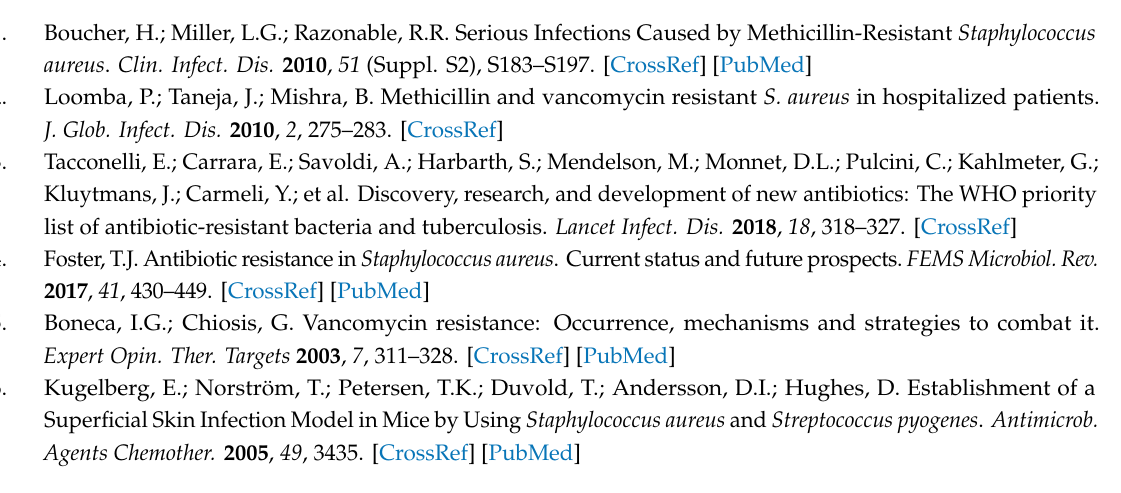
Figure S1: (a) SEM and (b) EDS elemental mapping. (c–h) stands for chloride, ruthenium, very less amount of carbon, negligible presence of sulphur, high amount of nitrogen, and less amount of oxygen; Figure S2: EDS spectrum where presence of ruthenium with high concentration of nitrogen can be seen; Figure S3: Growth curve of RuCl3 treated VRSA (CCM 1767); Figure S4: Growth curve of RuCl3 treated MRSA (ST239: SCCmecIIIA); Figure S5: Growth curve of 2-(1H-benzimidazol-2-ylmethylsulfanylmethyl)-1H-benzimidazole treatment against VRSA (CCM 1767); Figure S6: Growth curve of 2-(1H-benzimidazol-2-ylmethylsulfanylmethyl)-1H-benzimidazole treatment against MRSA (ST239: SCCmecIIIA); Figure S7: Growth curve of Schiff base 2- [(E)-1H-1,2,4-triazol-5-yliminomethyl] phenol treatment against VRSA (CCM 1767); Figure S8: Growth curve of Schiff base 2-((E)-1H-1,2,4-triazol-5-yliminomethyl) phenol treatment against MRSA (ST239: SCCmecIIIA); Figure S9 (a) cytotoxicity for RU-S4 against the human cell line; (b) PNT1A untreated and treated cells; (c) MTT assay of PNT1A cell line treated with RU-S4.; Figure S10: Healthy animal without any infection and treatment; Figure S11: Infected mice without drug administration. (a) after bacterial infection dose, (b) day 1 Infection initiation, (c) day 3 Infection and wound growth, (d) day 6 inflammation and swelling, with growing region internally as well; Figure S12: MMP Sense fluorescence intensity decreased day by day due to the treatment and cure of infection wound; Figure S13: Optical microscopy image of S. epidermidis ; Figure S14: LIVE / DEAD cell imaging of S. epidermidis ; Supplementary experimental setup 1, 1.1 Toxicological (LD100) studies in Bulb / c mice, 1.2. LD50 calculation, 1.3.